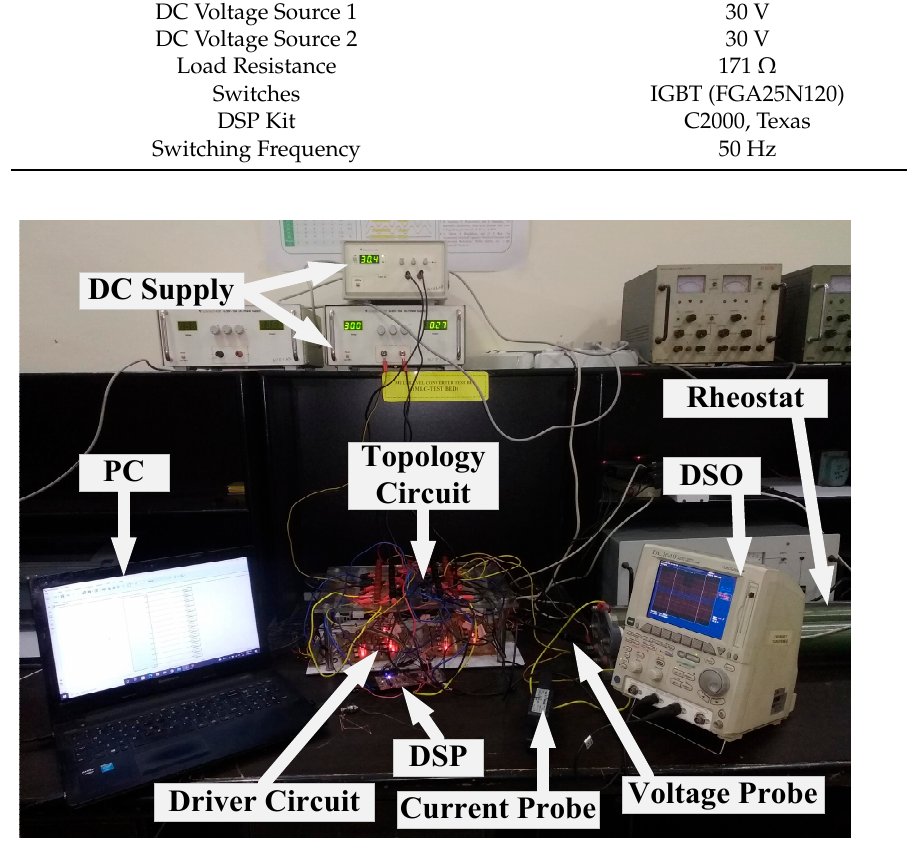
Figure 53. Experimental